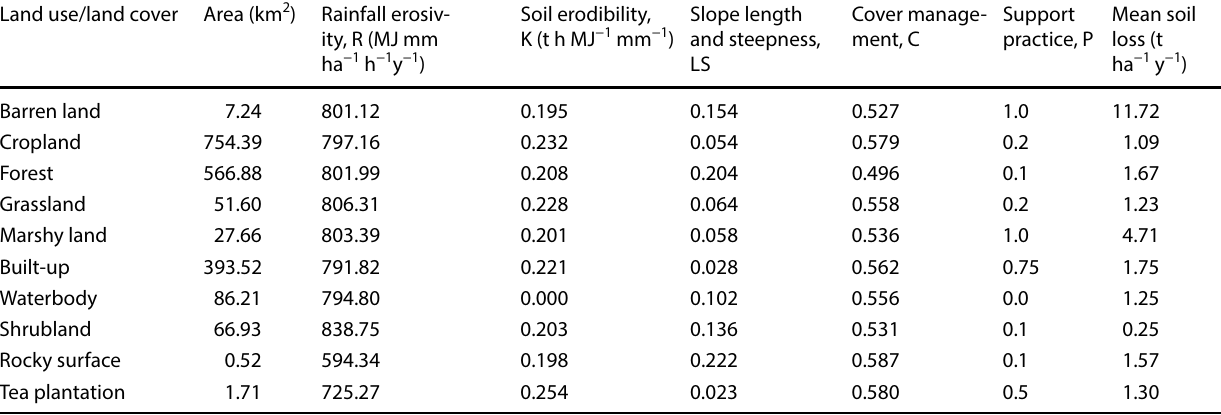
Table 3 Mean the value of soil erosion supporting factors on different land use/land cover classes of the study area Land use/land